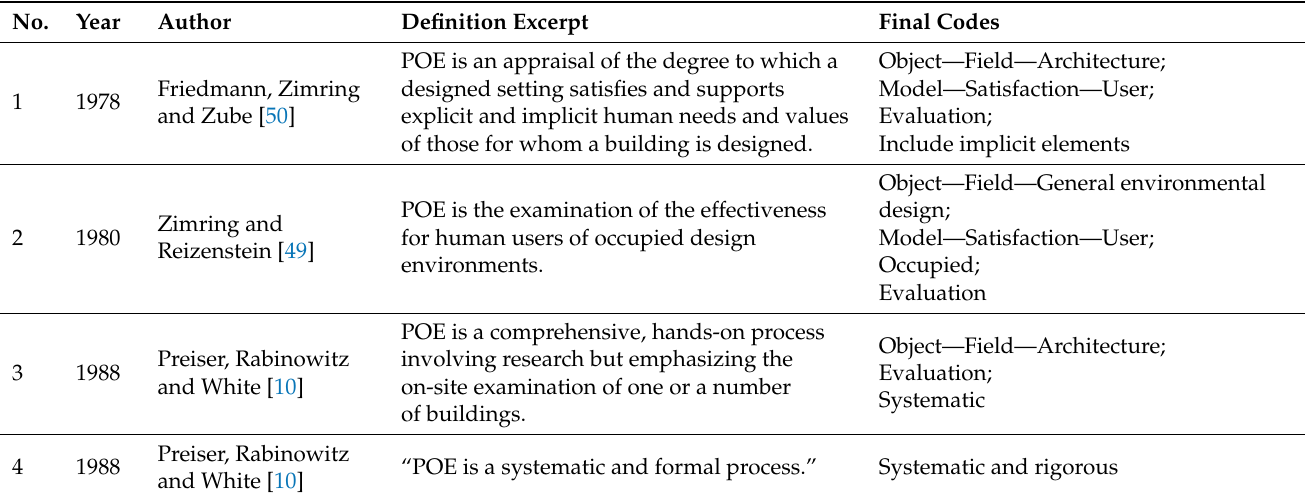
Table A4. Final Coding Result of POE